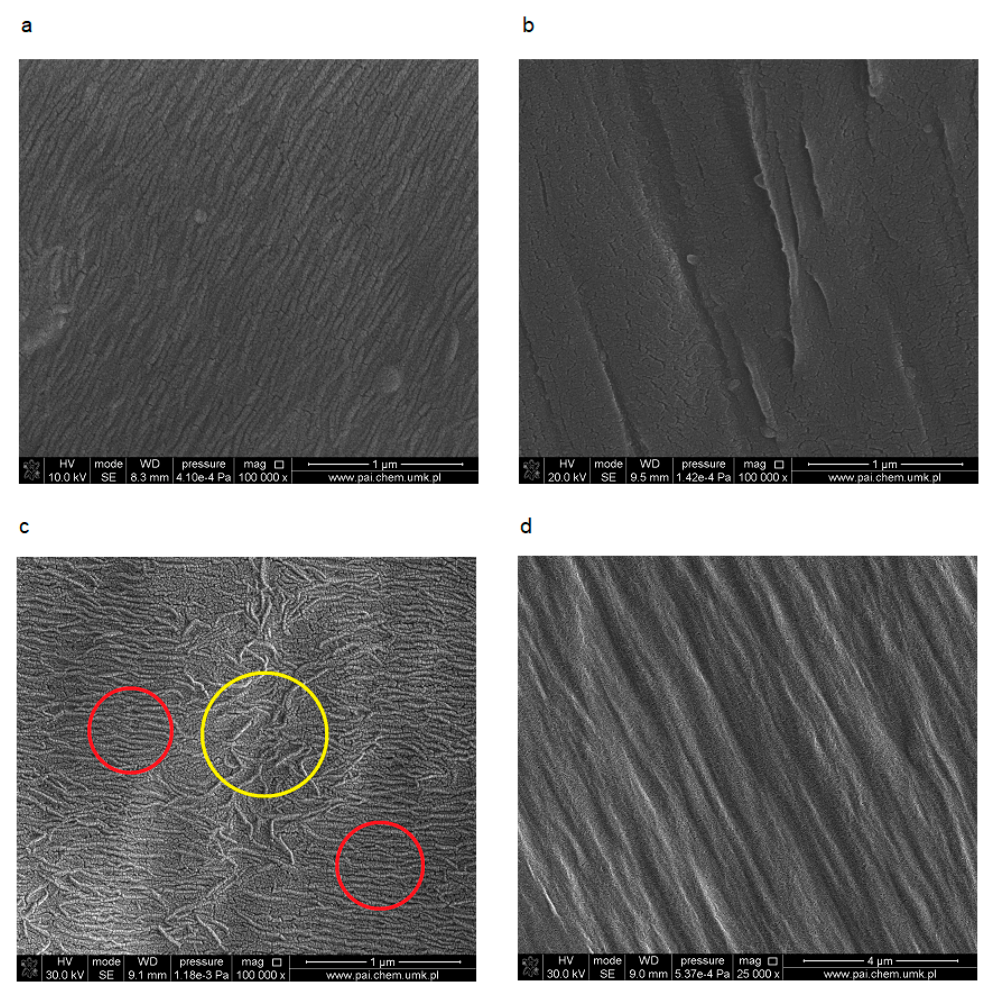
Figure 1. SEM images of HDPE ( a , b ) and MDPE ( c , d ): Non-oriented (on the left), oriented 3:1 (on the right); red circles indicate the domains with parallel packed fibrils, yellow circle shows entangled fibrous area.